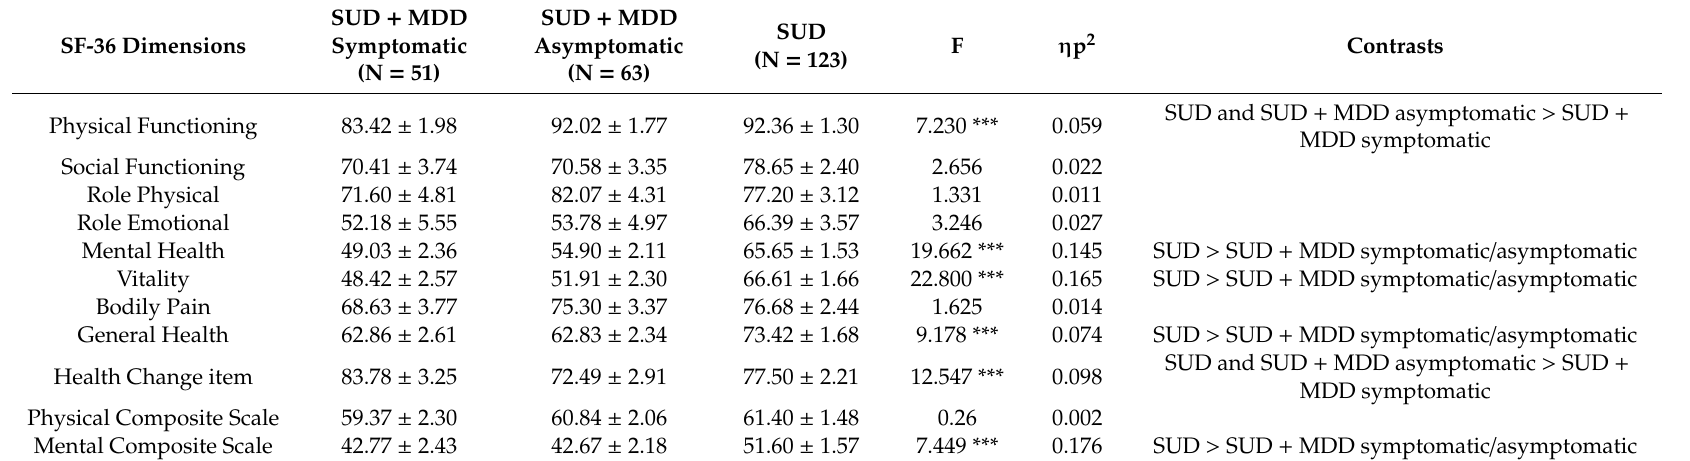
Table 4. Health-related quality of life results according to the diagnosis and presence / absence of depressive symptoms. Second MANCOA analysis with descriptive statistics (mean and standard error), normative data, F, and eta square ( η p 2 )